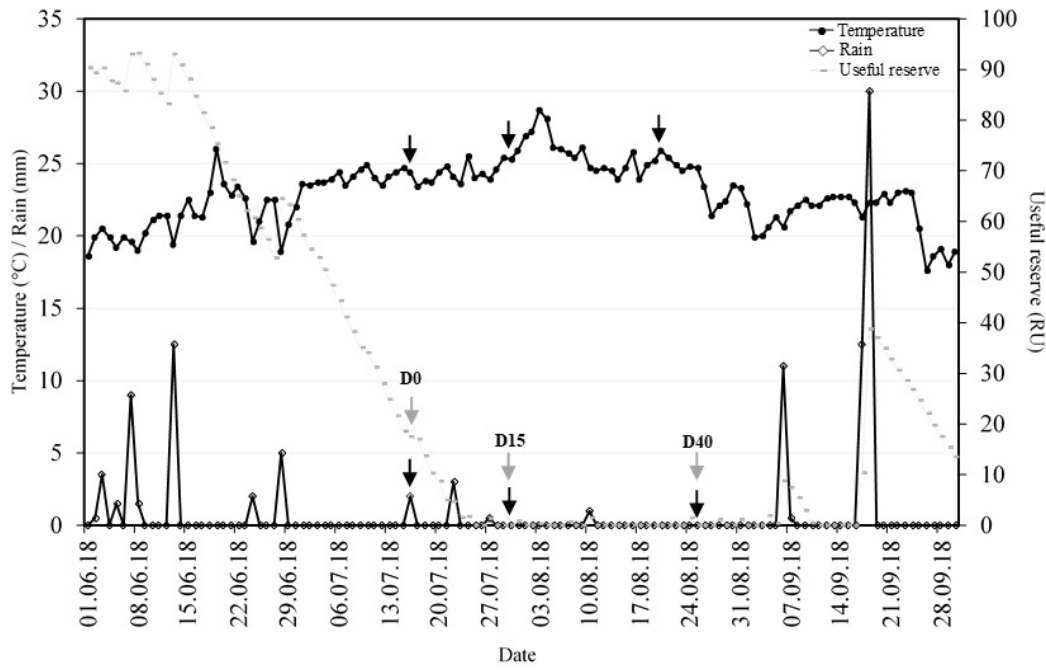
Figure 1. Meteorological data from June to 10 September 2018 in the orchard. Black circle symbols represent the mean daily temperature (°C). White diamond symbols correspond to the daily total rain (mm). Grey dash symbols correspond to the daily useful reserve (RU). The black and grey arrows correspond to the days of measurements and sampling: day 0 (D0) for the control, days 15 (D15) and 40 (D40) after the beginning of the experiment.